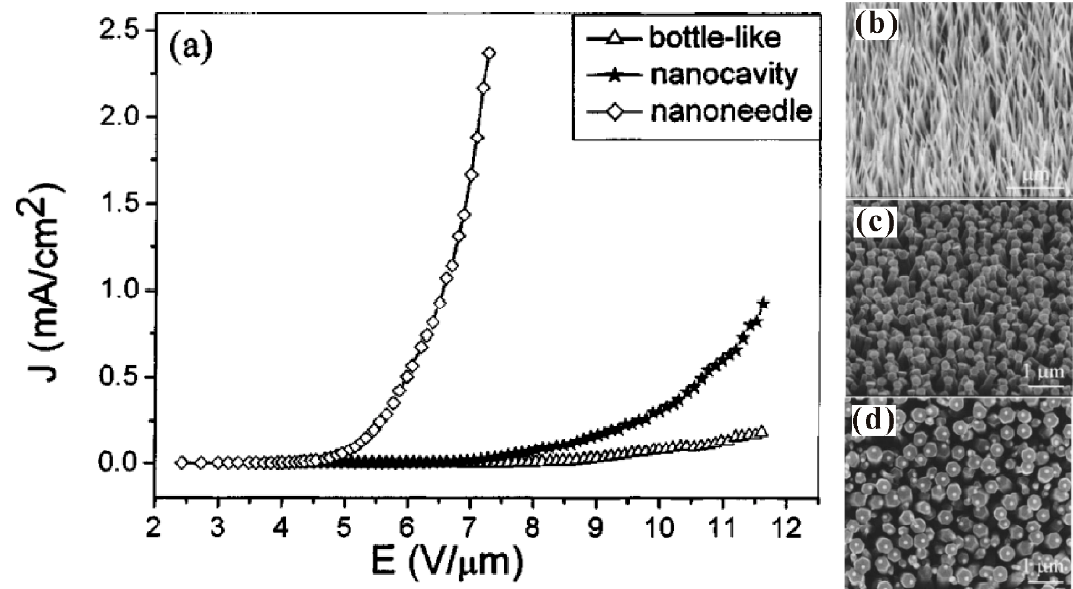
Figure 20. Influence of morphology on the field emission of ZnO nanorods. ( a ) Field-emission characteristics. ( b – d ) SEM images for ZnO nanorods with morphology of nanoneedle, nanocavity and bottle shaped. Reproduced from [85], with the permission of AIP Publishing, 2005.